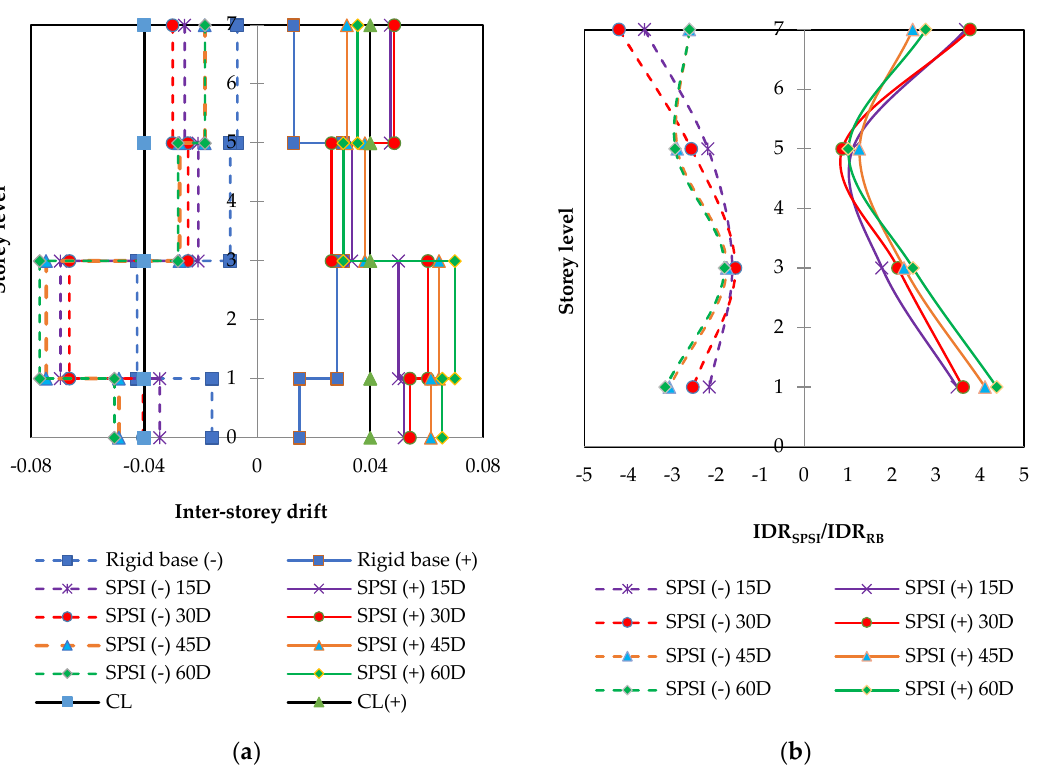
Figure 17. Effect of the L/D ratio on ( a ) the inter-story drift ratio and ( b ) IDR SPSI /IDR RB of soil-pile-supported structural models, compared to a fixed-base structure.